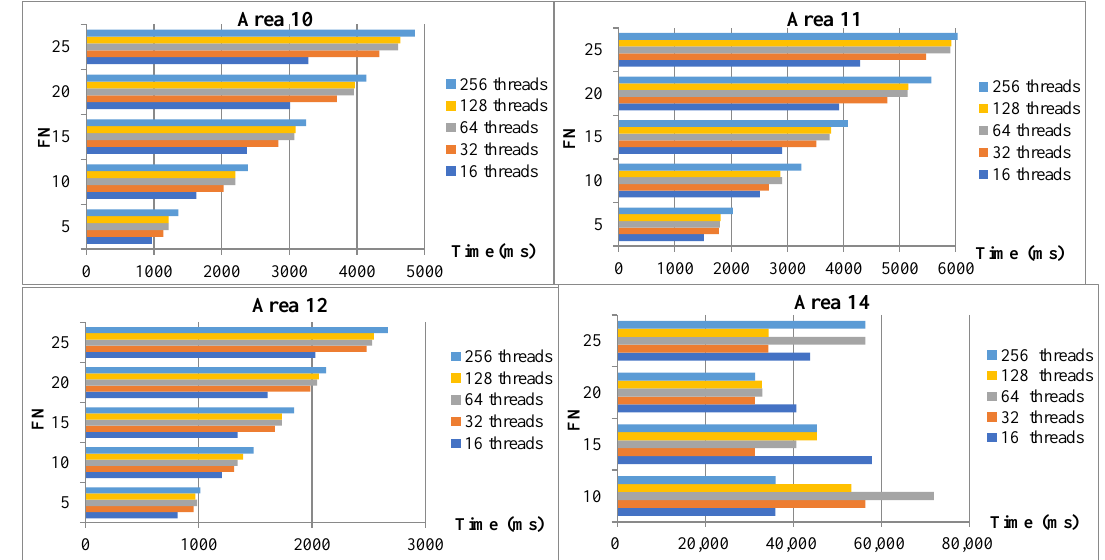
Figure 6. Time consumption of similarity computation in Area 10, Area 11, Area 12, and Area 14 under different combinations of FN and TN .